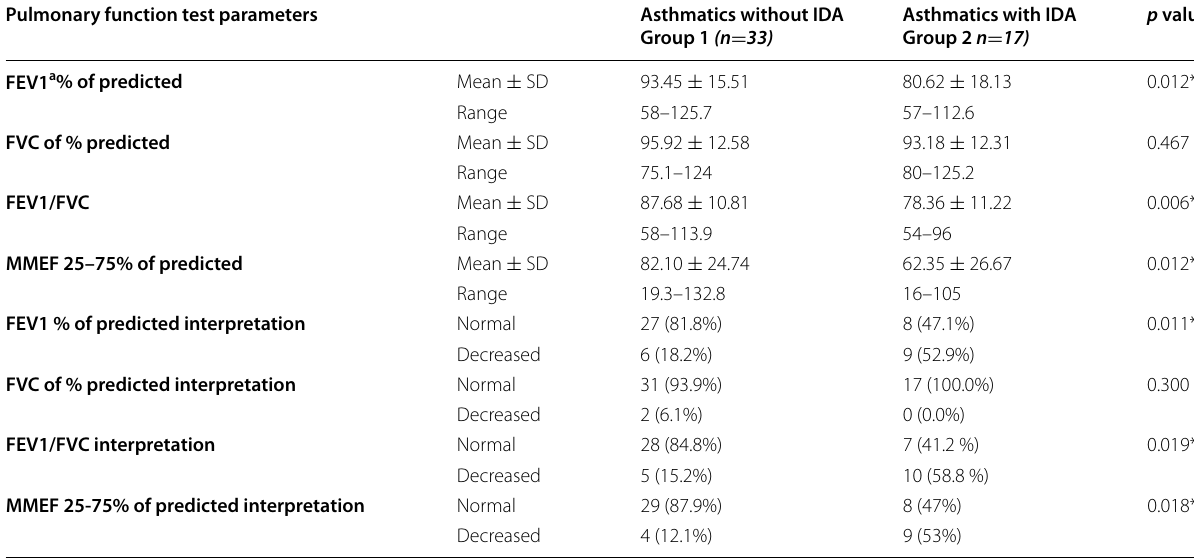
*p value <0.05 significant ; ** p value< 0.01, highly significant; IDA , iron deficiency anaemia; FEV1 , forced expiratory volume in 1 s; FVC , forced vital capacity; MMEF , maximal mid-expiratory flow